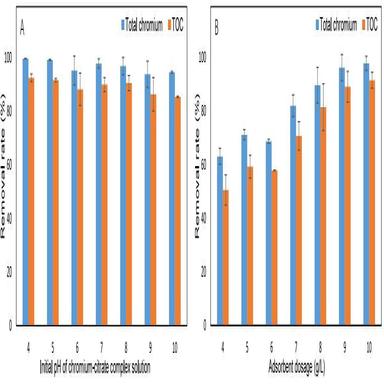
The variation pH value during treatment.